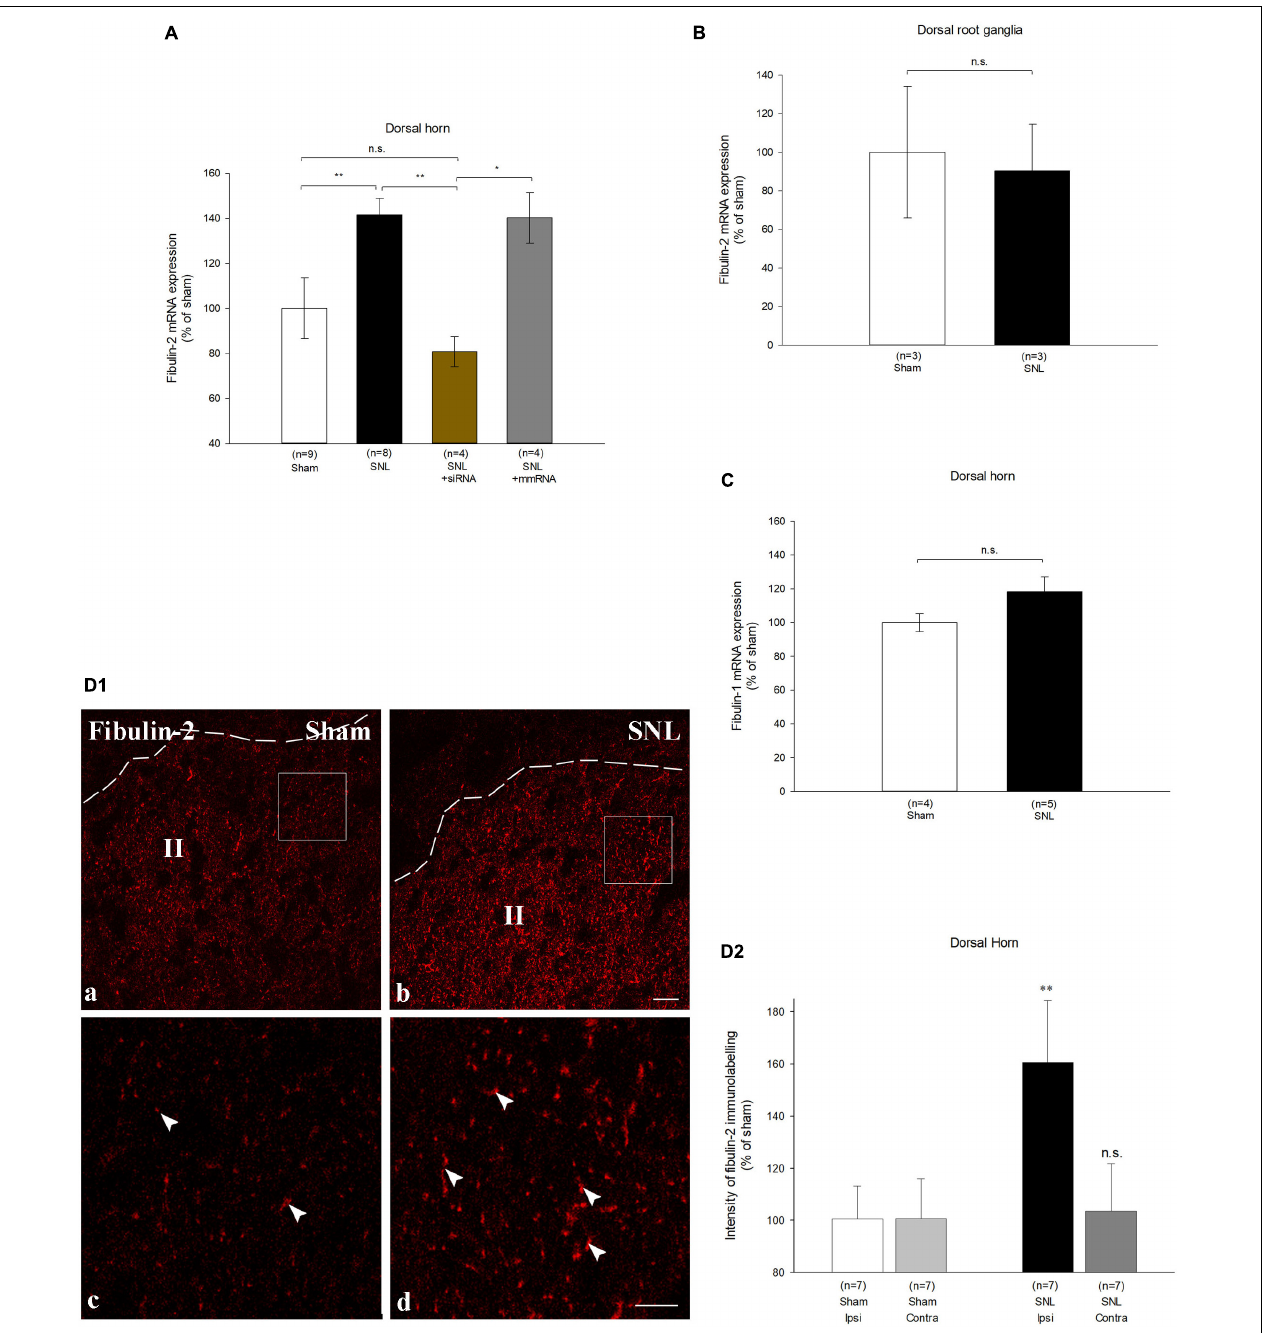
FIGURE 5 | Fibulin-2 is upregulated in the spinal cord of neuropathic rats. (A) qRT-PCR analysis of fibulin-2 mRNA in the ipsilateral spinal dorsal horn of sham rats, neuropathic rats (SNL), and SNL rats injected with anti-fibulin-2 siRNA (SNL + siRNA) or with mismatch RNA (SNL + mmRNA). Data are expressed as percentage of sham ± SEM. Fibulin-2 expression increased in ipsilateral dorsal horn of neuropathic rats. This increase was efficiently prevented by siRNA injection. The injection of mmRNA had no effect on fibulin-2 expression. * p < 0.05, ** p < 0.01 “sham” vs. “SNL”; n.s.: p > 0.05. (B) qRT-PCR analysis of mRNA of fibulin-2 in the ipsilateral dorsal root ganglia of sham and neuropathic (SNL) rats. Data are expressed as percentage of sham ± SEM. No significant changes are seen (n.s.: p > 0.05 “sham” vs. “SNL). (C) qRT-PCR analysis of mRNA of fibulin-1 in the ipsilateral spinal dorsal horn of sham and neuropathic (SNL) rats. Data are expressed as percentage of sham ± SEM. No significant changes are observed (n.s.: p > 0.05 “sham” vs. “SNL). (D1) Immunohistochemistry for endogenous fibulin-2 in the ipsilateral dorsal horn of sham (a) , and neuropathic (SNL) (b) rats. The dotted line indicates the dorsal limit of the spinal cord section. Framed areas of the lamina II (II) in (a,b) are displayed at higher magnification in (c,d) , respectively. Fibulin-2 expression was very low in sham animals (arrowheads in c ) whereas an intense staining could be seen in the SNL group (arrowheads in d ). (D2) The quantification of the signal intensity confirmed the significant difference in the ipsilateral dorsal horn between sham and SNL groups. In contrast, no changes is seen in the contralateral dorsal horn ( n = 3 sections from 7 animals in sham and SNL groups). ** p < 0.01; n.s.: p > 0.05.